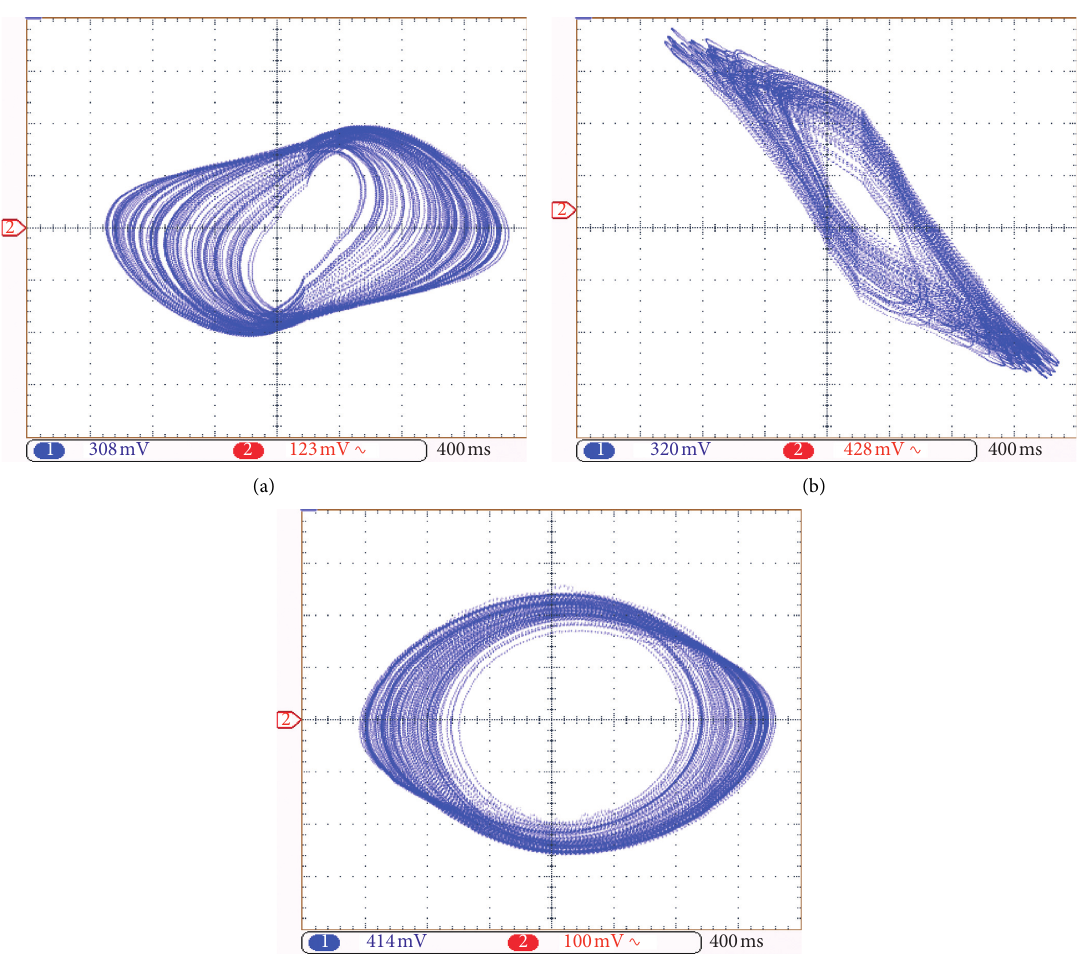
Figure 6: Hidden attractors by DSP implementation for a � 8.4562; b � 12.0732; c � 0.0052; m � –1.1468; n � –0.1768: (a) x - y plane; (b) x - z plane; (c) y - z